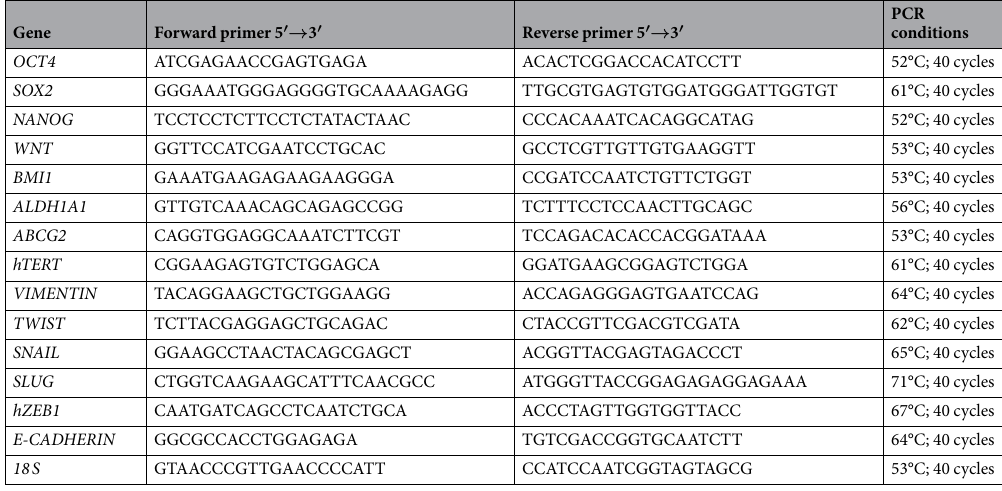
Table 1. Primers and PCR conditions used for